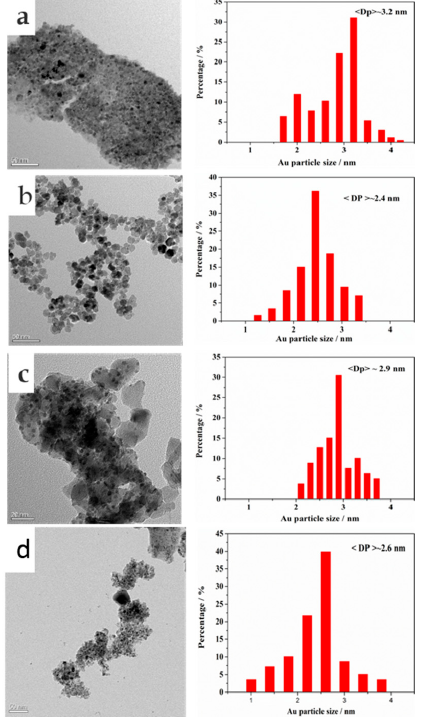
Figure 4. TEM images and the distribution of gold particle size of catalysts ( a ) Au/ZrO 2 ; ( b ) Au/Ce 0.4 Zr 0.6 O 2 ; ( c ) Au/CeO 2 ; ( d ) the reused catalyst after five runs.